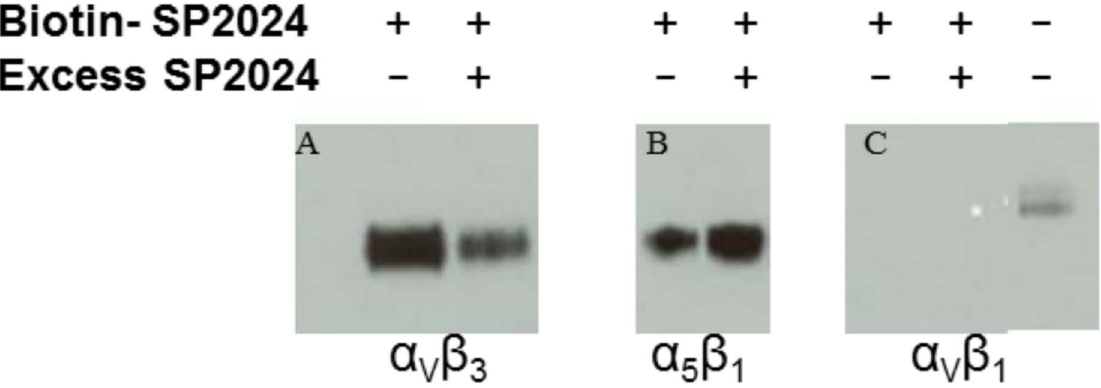
Figure 4. Binding of the peptides to the integrins. Specific binding of the biotinylated peptide to specific integrins involved in regulation of angiogenesis. Panel A shows the specific binding to the integrin a V b 3 , in contrast to non-specific binding to the a 5 b 1 (panel B). Panel C indicates no binding to the a V b 1 integrin.